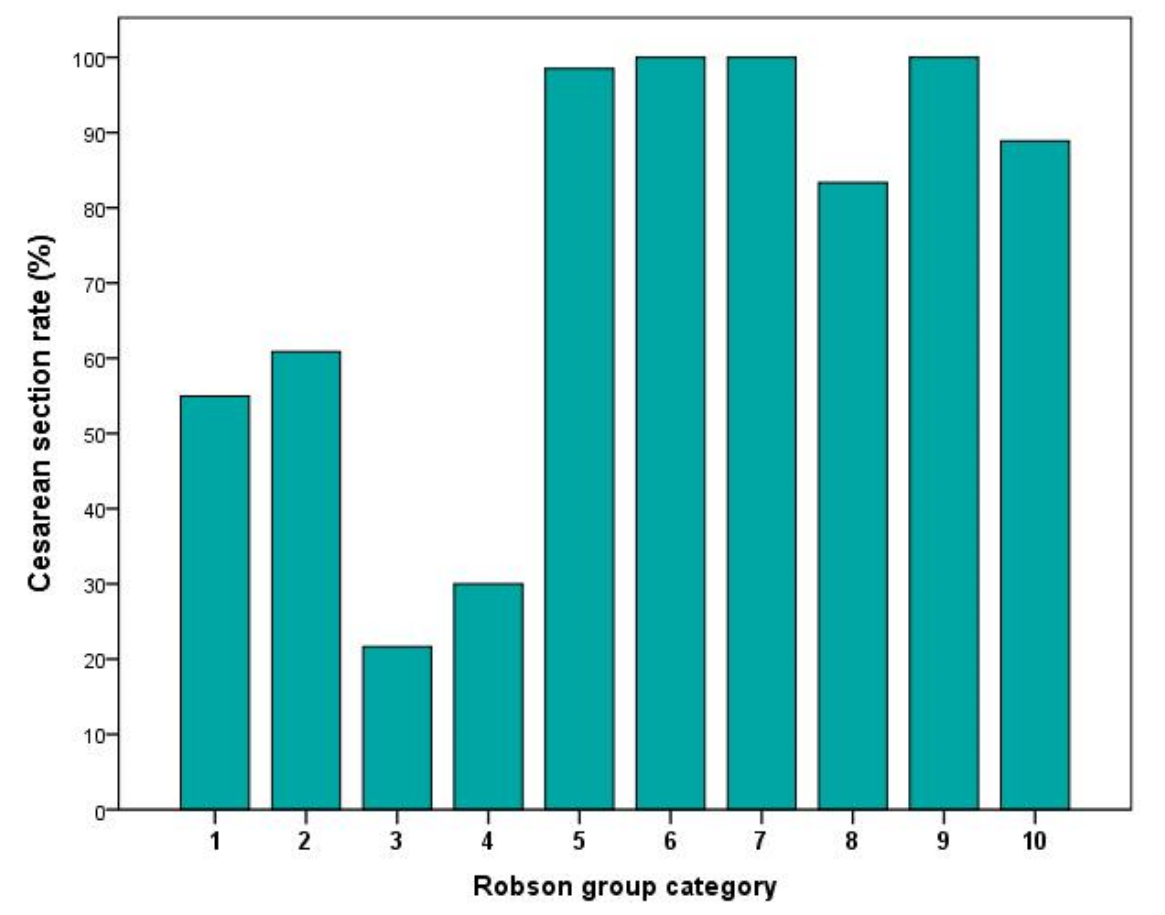
Figure 1. Caesarean section rate of included COVID-19 pregnancies, according to the Robson group category. Table 3. Maternal characteristics and perinatal outcome of included COVID-19 pregnancies, according to the time period. Data presented as n (%) or median (interquartile